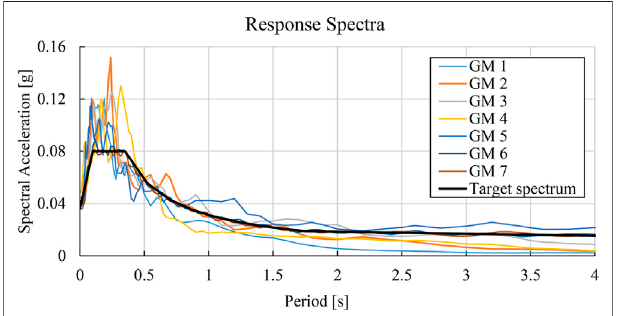
FIGURE 11 | Ground-motion selection and response spectra.